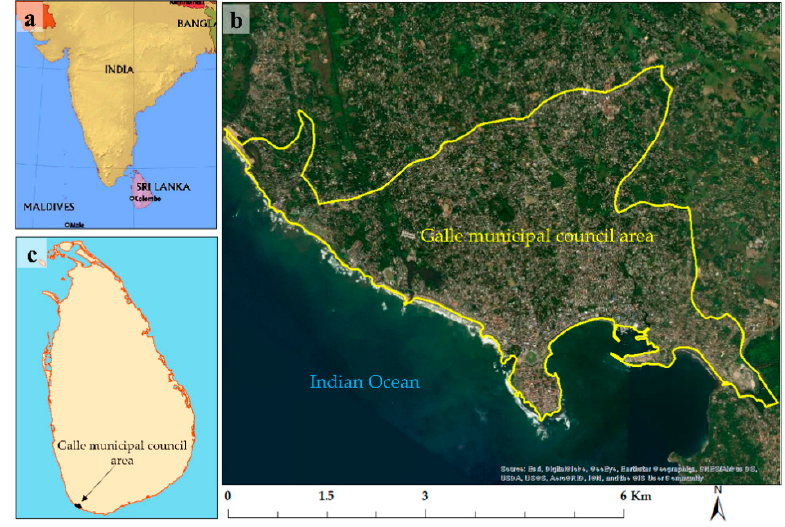
Figure 1. Study area: ( a ) South Asia, ( b ) Sri Lanka, and ( c ) study area represented with a Google Earth Image (access date on 10 March 2020).